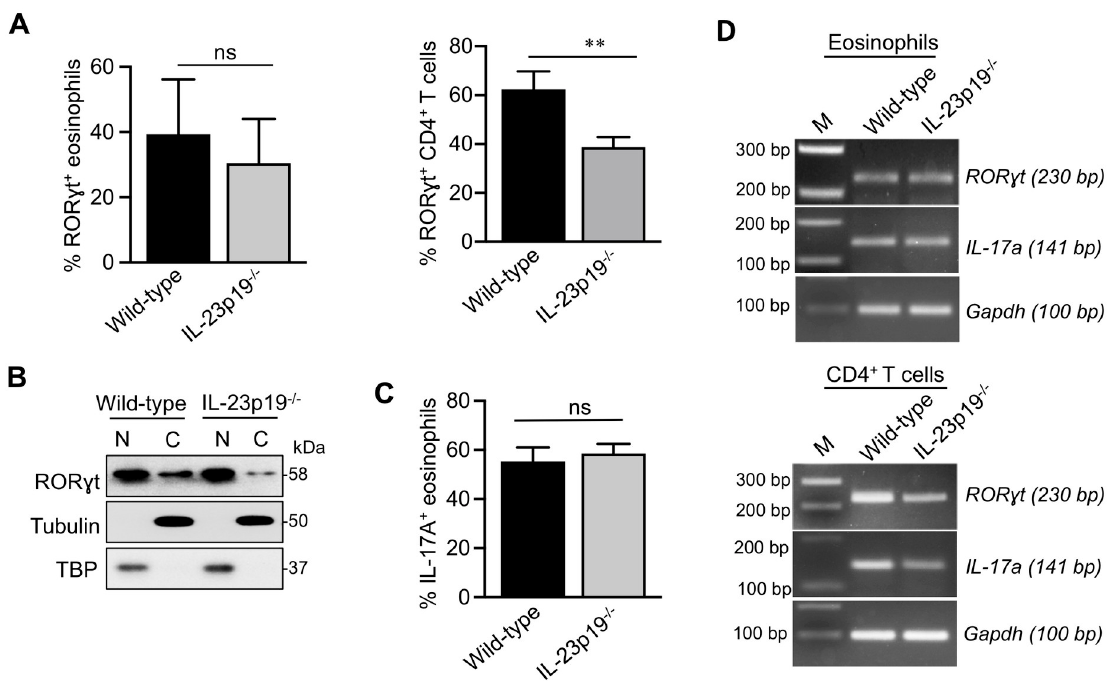
Fig 6. ROR γ t and IL-17 expression in lung eosinophils and CD4 + T cells from wild-type versus IL-23p19 deficient mice with allergic aspergillosis. (A) ROR γ t expression by flow cytometry . Allergic aspergillosis was induced in wild-type and IL-23p19 -/- mice as described in Fig 1A. Upper panel: Gated lung eosinophils were analyzed for ROR γ t staining by flow cytometry with ICS. The bar graphs show the percent ROR γ t + eosinophils in wild-type and IL-23p19 -/- mice in three separate experiments, each of which had 4–5 mice per group. Data are means ± SEM (ns, not significant). Lower panel: As in the upper panel except lung CD4 + T cells, gated based on positive staining for CD45, CD3 and CD4, were stained for ROR γ t. Data shown in the bar graphs are means ± SEM of an experiment with 4 mice/group (p < 0.01). (B) Immunoblotting for ROR γ t . Allergic aspergillosis was induced in wild-type and IL-23p19 -/- mice as shown in Fig 1A. Eosinophils were purified from total lung cells by FACS-sorting, separated into cytoplasmic (C) and nuclear (N) fractions and analyzed for ROR γ t by immunoblotting, as described in Fig 2C. TBP and α -Tubulin served as nuclear and cytoplasmic controls, respectively. (C) IL-17 expression by flow cytometry . Allergic aspergillosis was induced in wild-type and IL-23p19 -/- mice as shown in Fig 1A. Lungs were harvested, and single cell preparations were made. Gated lung eosinophils were analyzed for IL-17 staining by flow cytometry with ICS. The bar graphs show the percent eosinophils in wild-type and IL-23p19 -/- mice in two separate experiments, each of which had 4–5 mice per group. Data are means ± SEM (ns, not significant). (D) RT-PCR analysis . Allergic aspergillosis was induced in wild-type and IL-23p19 -/- mice as shown in Fig 1A. Lung eosinophils (left panel) and CD4 + T cells (right panel) were purified by flow-sorting following which their RNA was analyzed by RT-PCR for the expression of ROR γ t and IL-17a . Gapdh expression served as a loading control. M: DNA markers, as in Fig